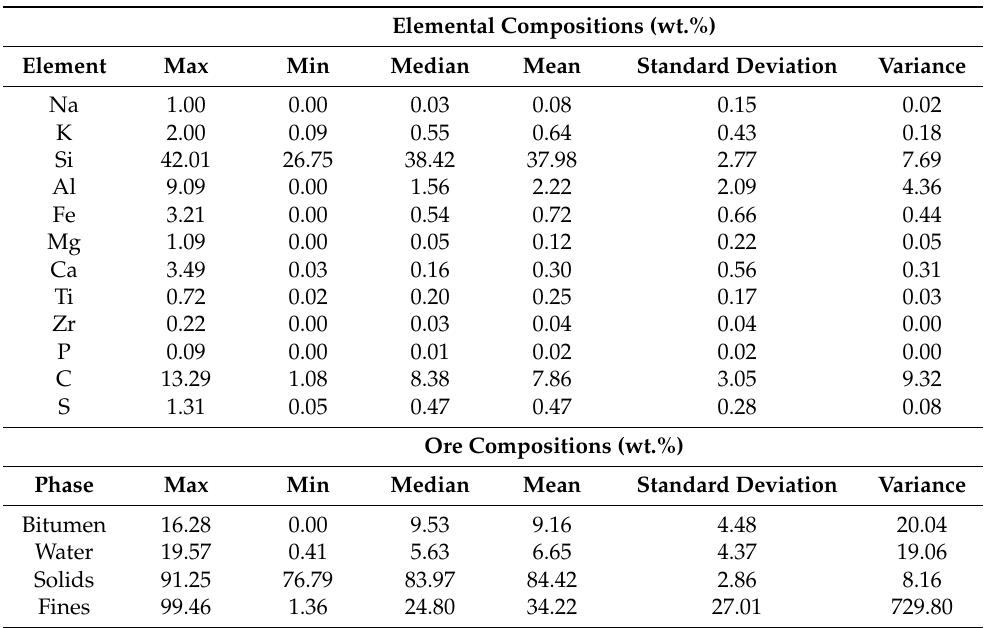
Table 2. Summary of descriptive statistics for elemental and ore compositions analyzed by X-ray fluorescence (XRF) and Soxhlet-Dean and Stark extraction (respectively) in 60